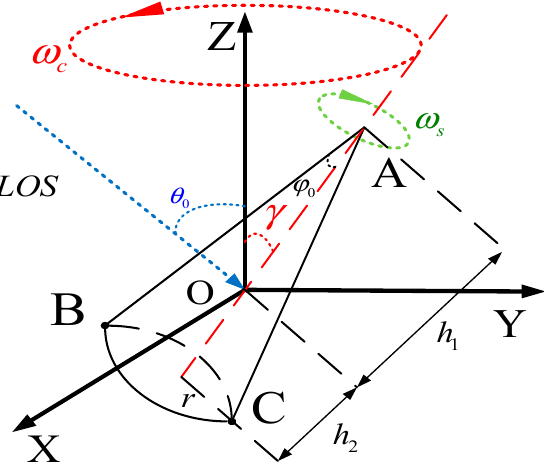
Figure 1. Micro-motion model of cone-shaped precession